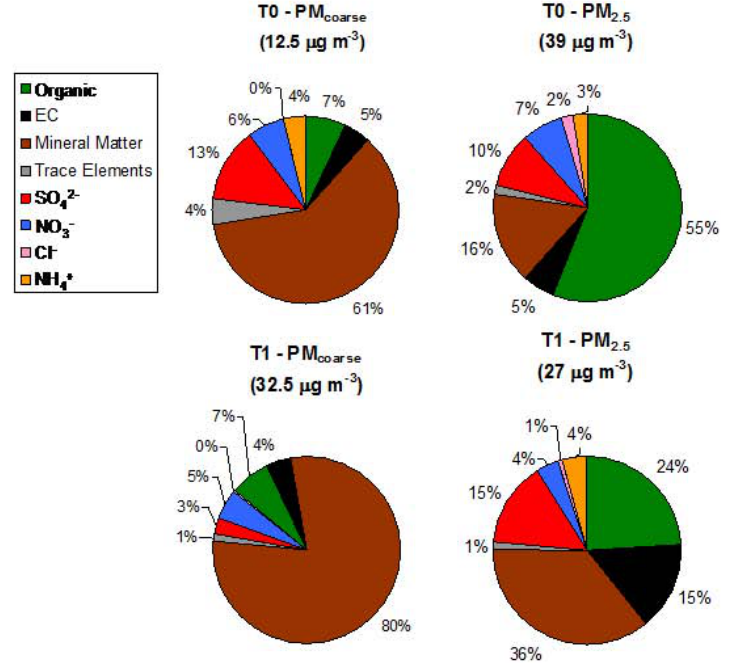
Fig. 12. Average composition of PM coarse (PM 10 –PM 2 . 5 ) and PM 2 . 5 at the T0 and T1 supersites, based on the results of Querol et al. (2008). OA was calculated from the measured OC based on the average measured OA/OC ratio of 1.75 at T0 (Aiken et al., 2008). The T1 site was affected by local resuspension of dust, which explains the unusually large contribution of mineral matter at this